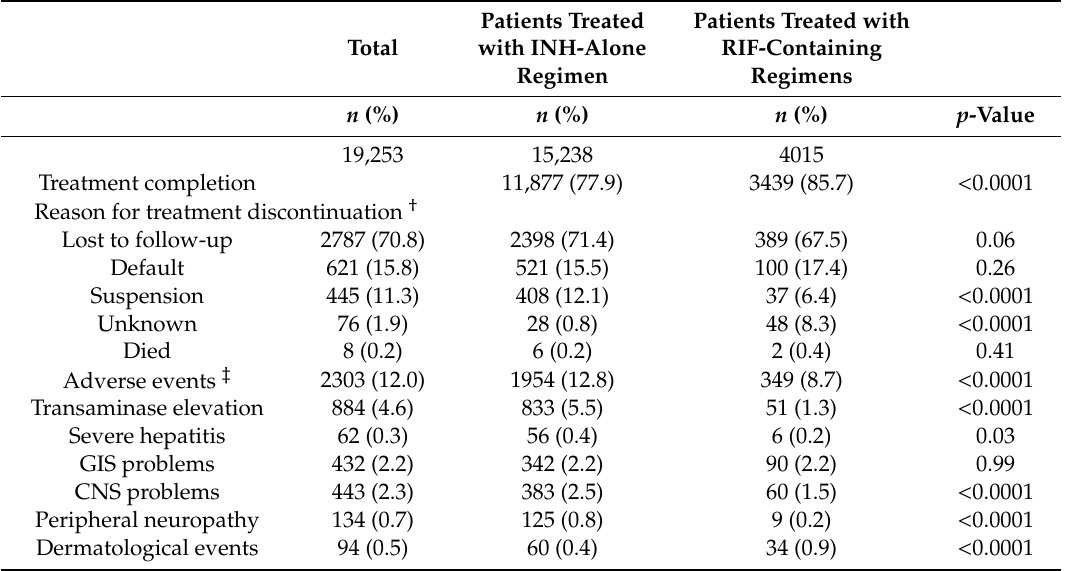
Table 5. Comparison of treatment outcomes and AEs between RIF-containing regimens and INH-alone regimen without therapy changes ( n = 19,253).